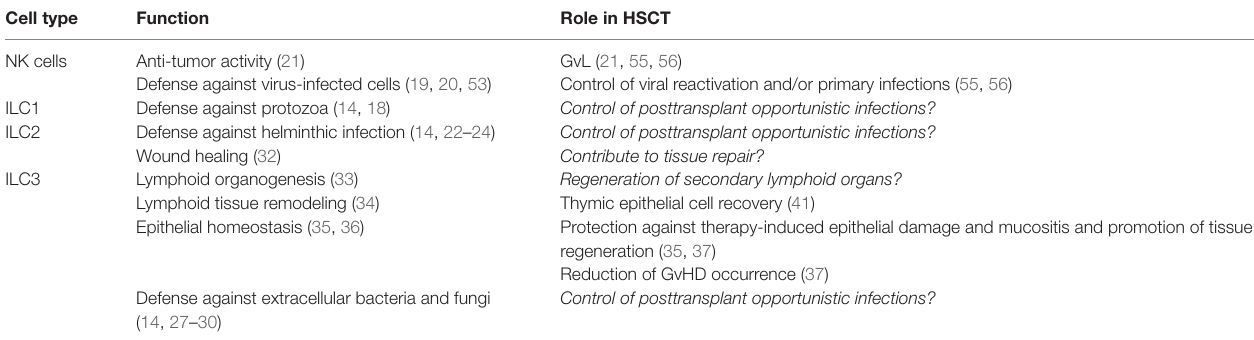
TABLe 1 | This table summarizes the main function exerted by distinct iLC subsets and the possible role exerted by these cells in the context of HSCT.